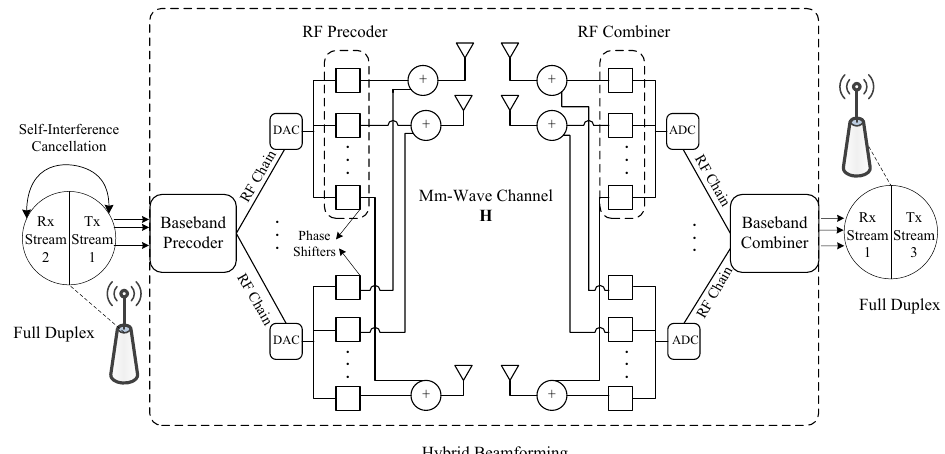
Figure 2. Physical layer techniques: hybrid beamforming and full